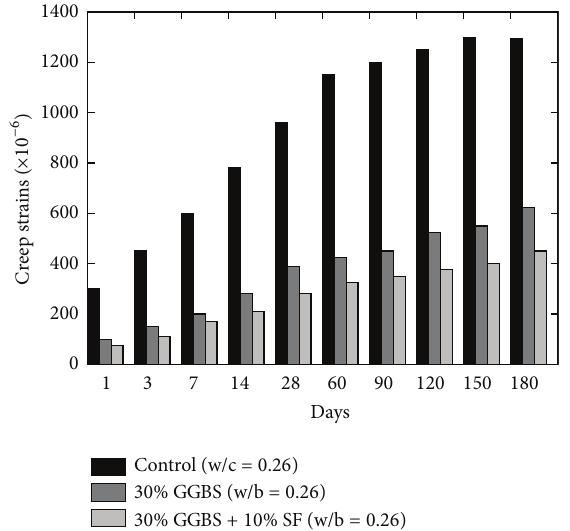
Figure 4: Effect of plain and blended GGBS on the creep strain of GGBS concrete